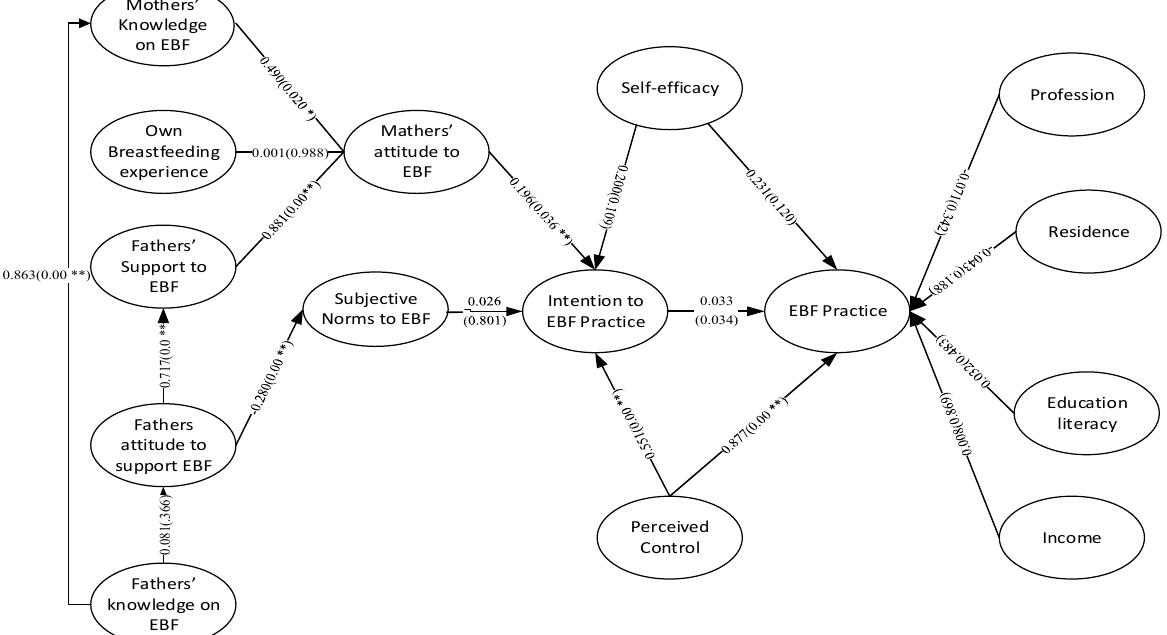
Figure 3. Multi group analyzing the role of father’s knowledge and attitude on mother’s BF knowledge, attitude and practice in Bangladesh (on cesarean delivery subsample). * Significant at p < 0.05; ** Significant at p < 0.01.